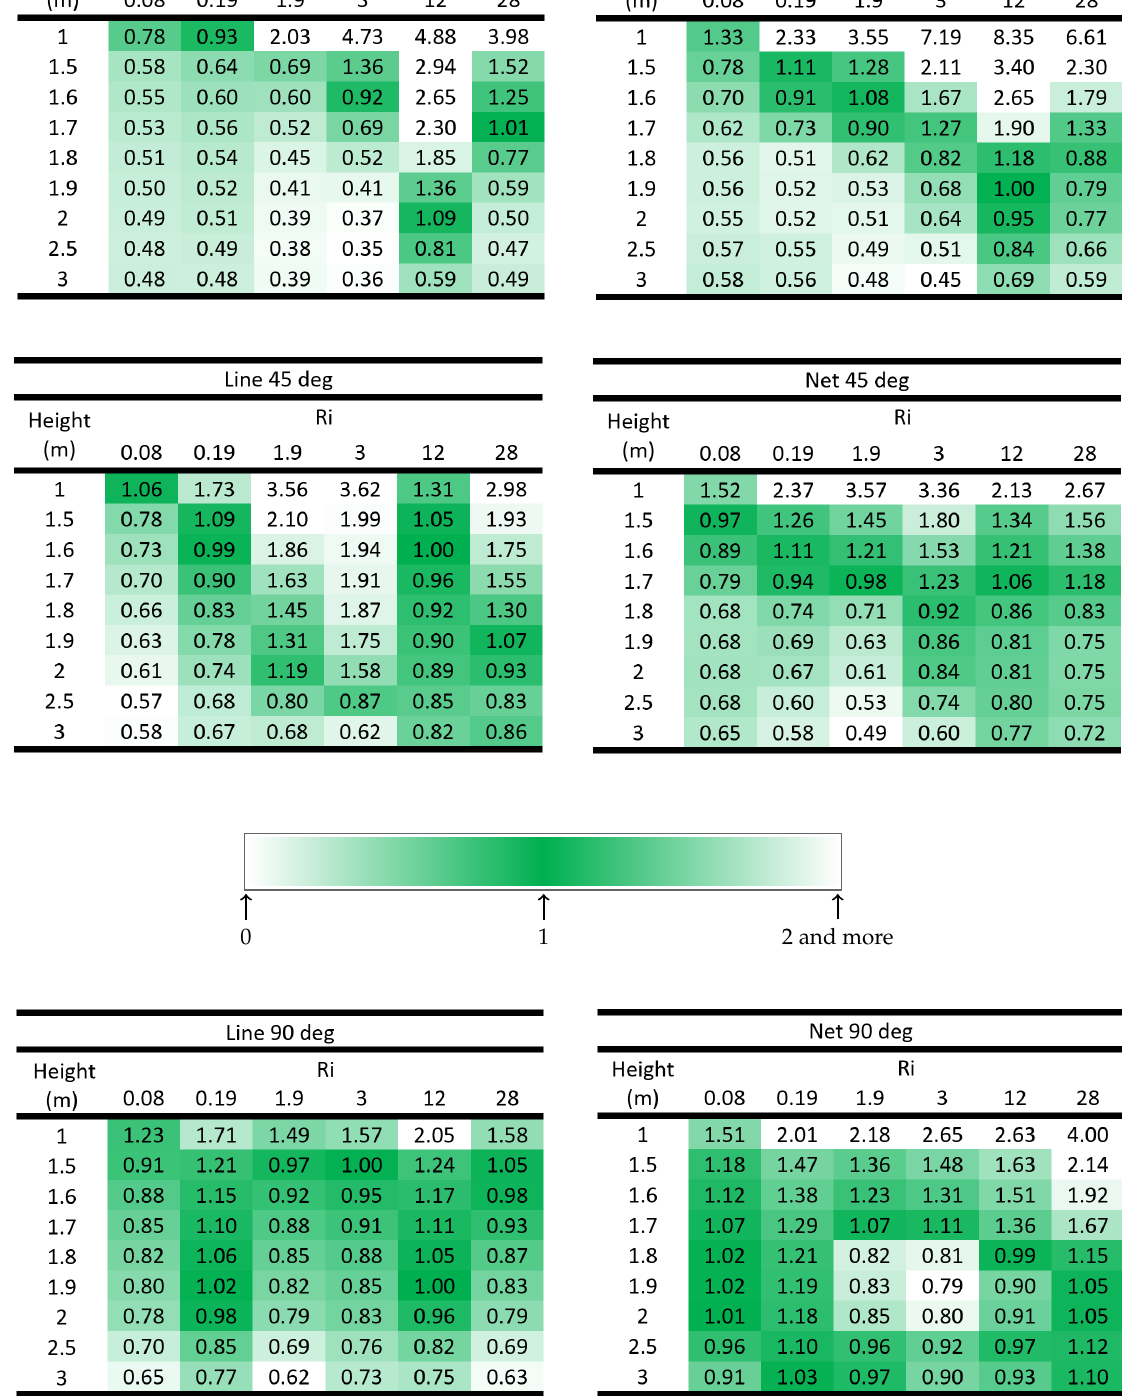
) ( M ) source ) with the lines and net / line )/( NH 3 / CO 2 3 / CO 2